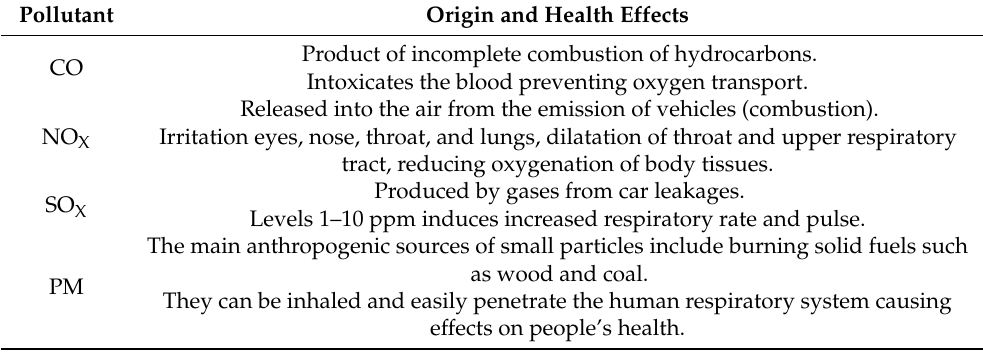
Table 1. Air pollutants.